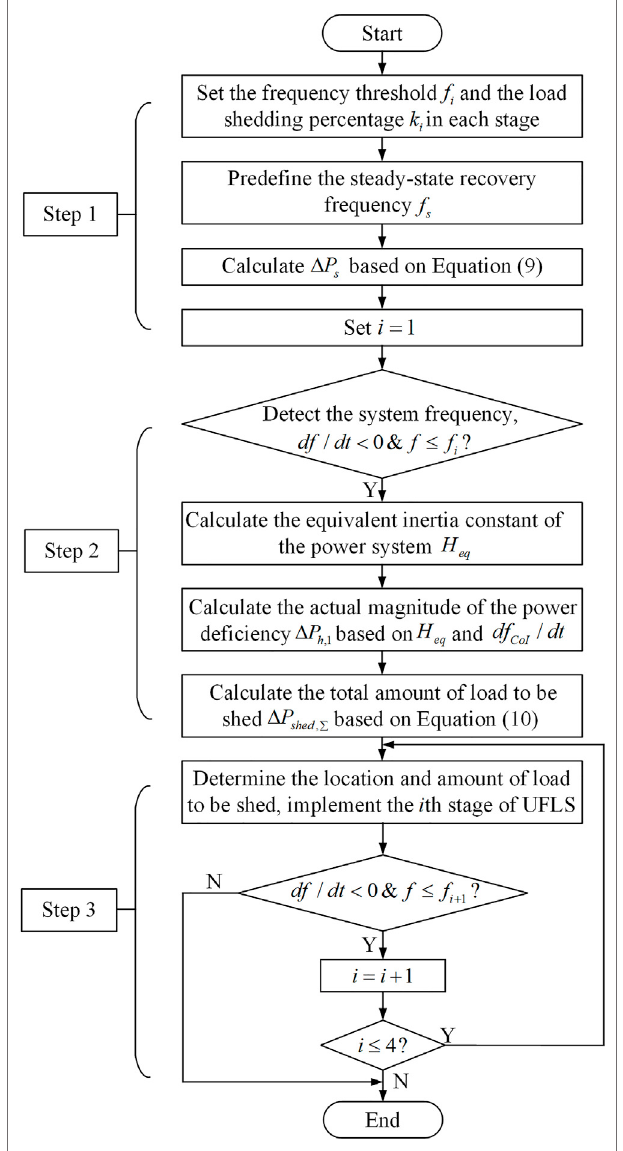
FIGURE 6 | Flowchart of the proposed UFLS control